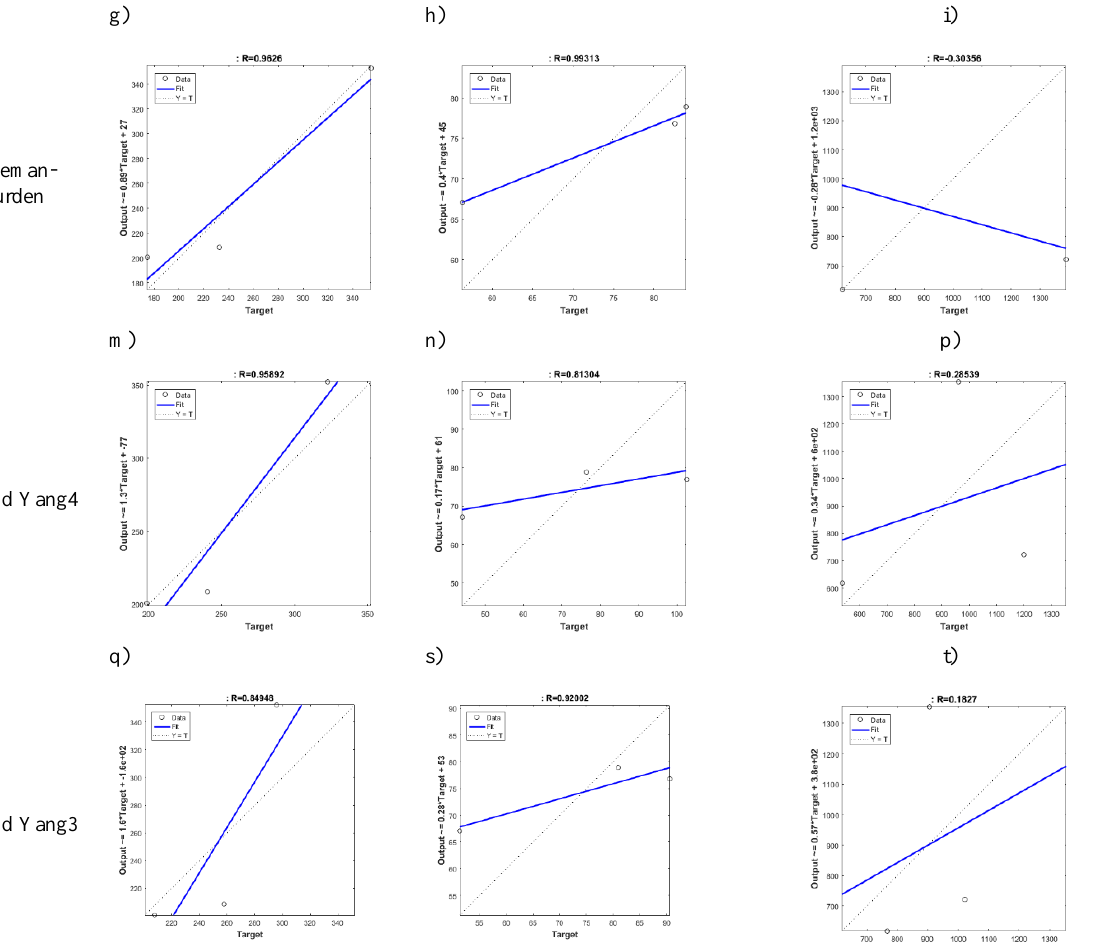
Figure 5. Plots of Regression for each crop in different